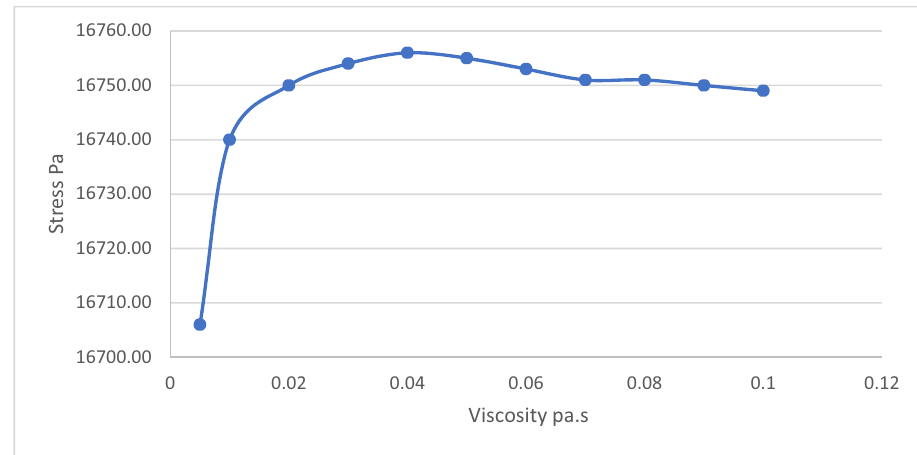
Figure 7: Stress gradient in the inlet section.